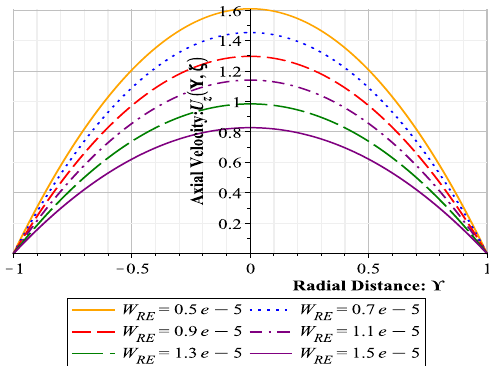
Figure 2. Behavior of U z ( γ , ζ ) with γ at ζ = 0.5 for different values of W RE